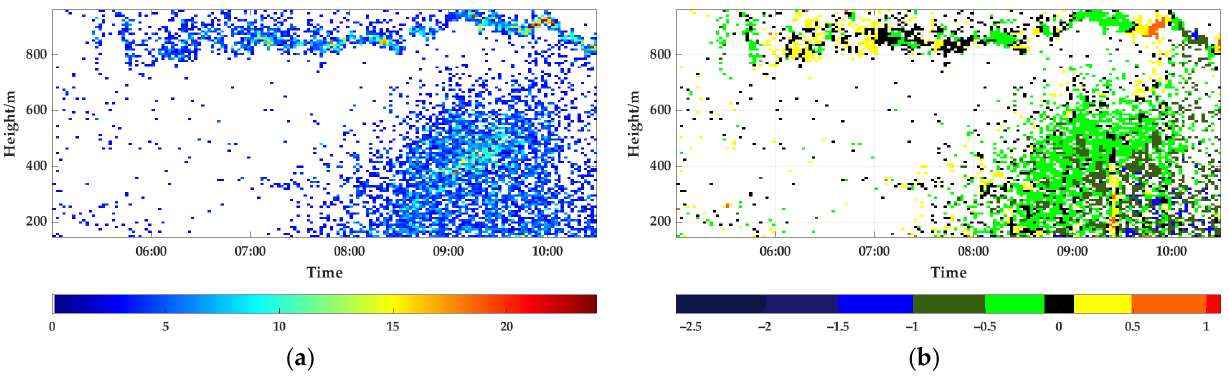
Figure 19. Relationships between the number and the ascent/descent rates with the height and time for insects with typical landing behavior: ( a ) distribution of number with height and time; ( b ) dis- tribution of ascent/descent rate with height and time. The sunrise occurred at 04:54